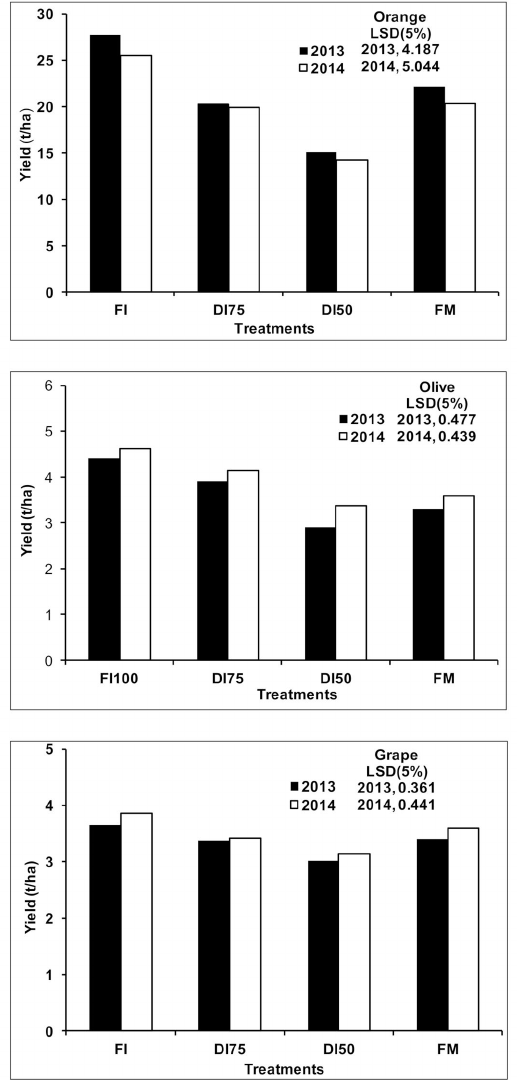
Figure 5. Yields of orange, olive, and grapevine under the irrigation treatment and a year of production for full (FI), deficit (DI75, DI50), and grower’s (FM) irrigation methods. LSD is the least significant difference between treatments. Table 1. Orange fruit yield and quality parameters under irrigation strategies for the study periods 2013 and 2014. Parameters Fruit Weight (g/fruit)